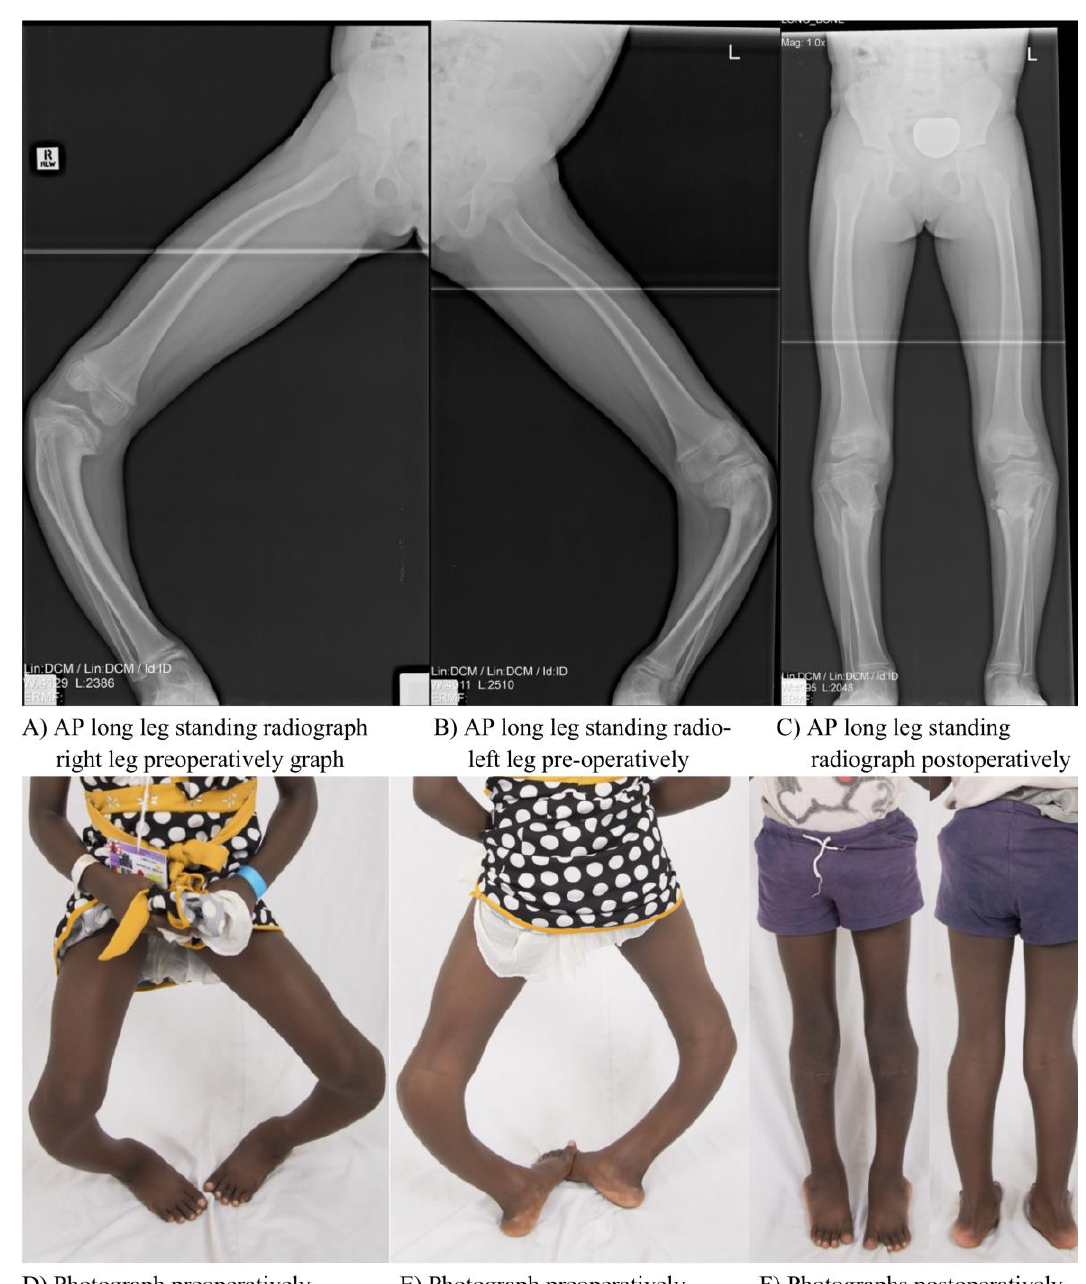
Figure 2. ( A – F ) Clinical example with AP long leg standing radiographs and photographs pre- and